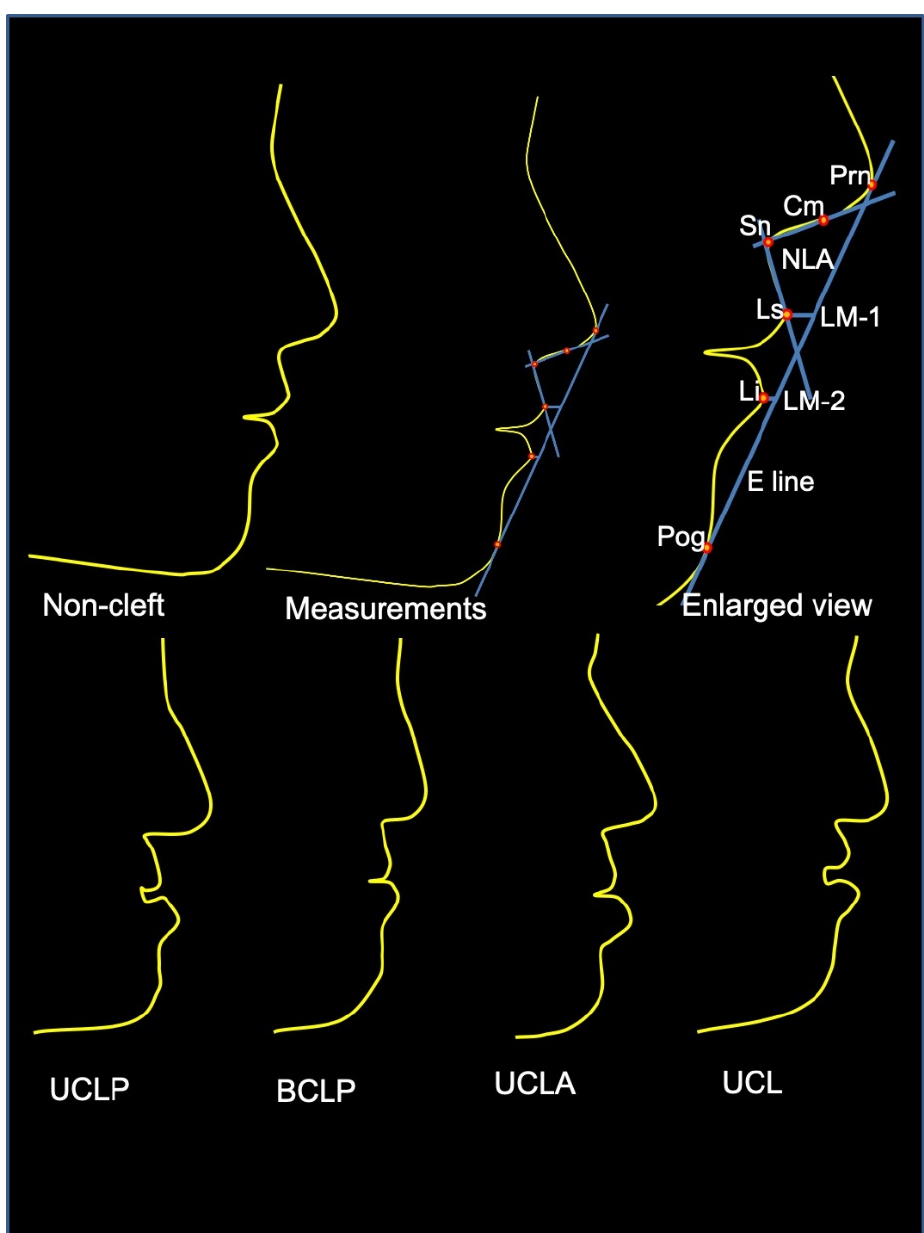
Figure 1. Profile view of non-cleft, unilateral cleft lip and palate (UCLP), bilateral cleft lip and palate (BCLP), unilateral cleft lip and alveolus (UCLA), and unilateral cleft lip (UCL) and soft tissue land- marks, angular, and linear measurements used in this study. Table 1. Soft tissue landmarks, angular, and linear